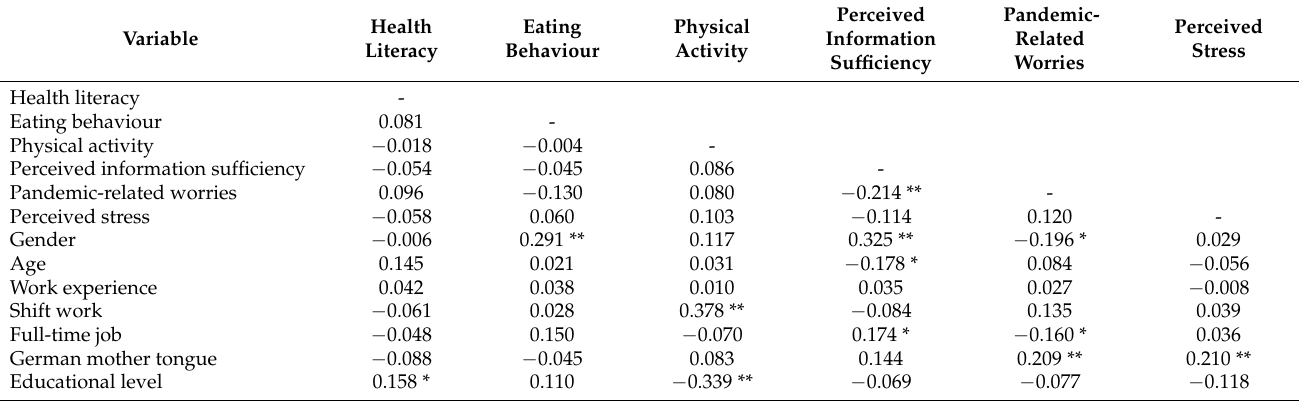
Health Eating Literacy Behaviour